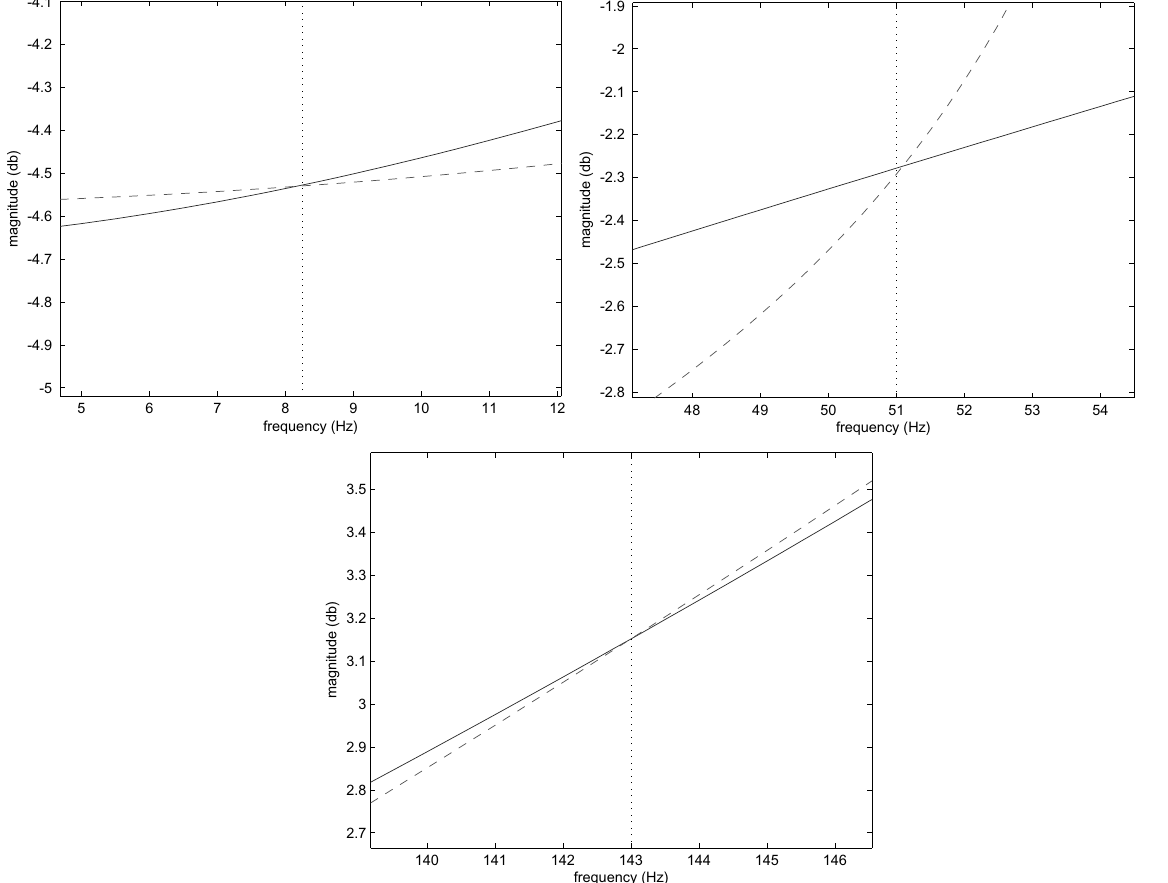
Fig. 15. Transmissibility function between point 7 and point 8 for undamaged structure for loading case 1 (full line, force applied in DOF 1) and loading case 2 (dashed line, force applied in DOF 3).